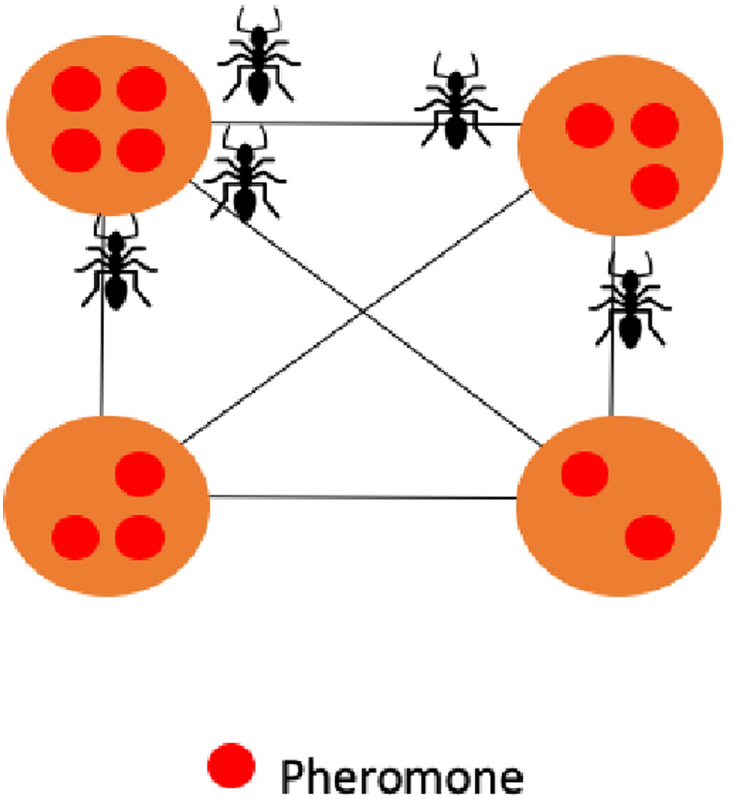
Fig 13. Ant colony pheromone representation.